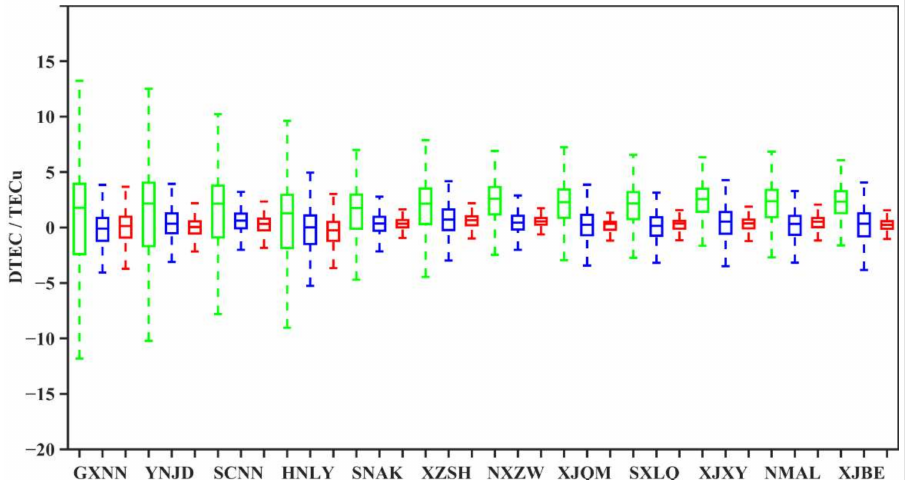
Figure 8. Boxplots of the differences (DTEC) between GNSS-TEC and the TEC estimates calculated using the original IRI-2016 model, scheme A and scheme B at 12 verification stations in 2019 (green, blue, and red boxes correspond to IRI-2016, scheme B and scheme A,